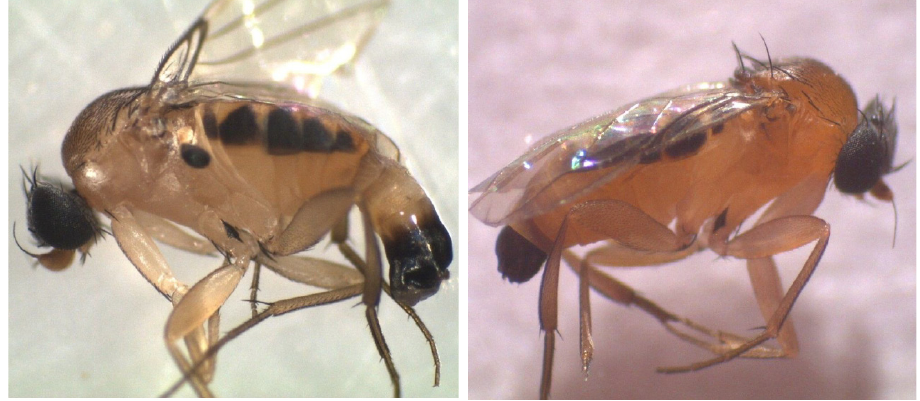
Fig 4 . Species collected from the genus Eibesfeldtphora